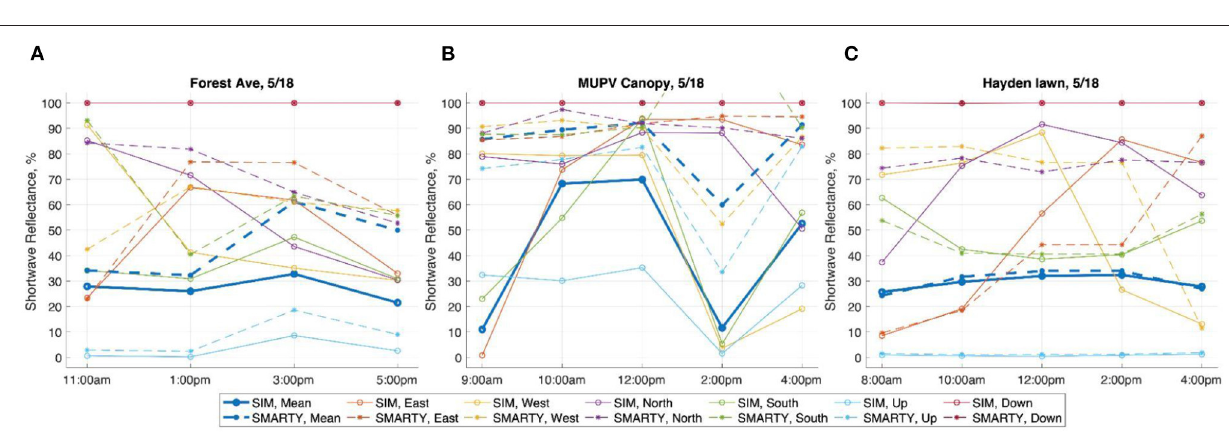
(797.6 W · m − 2 ) without shade above. Because of the PV panels